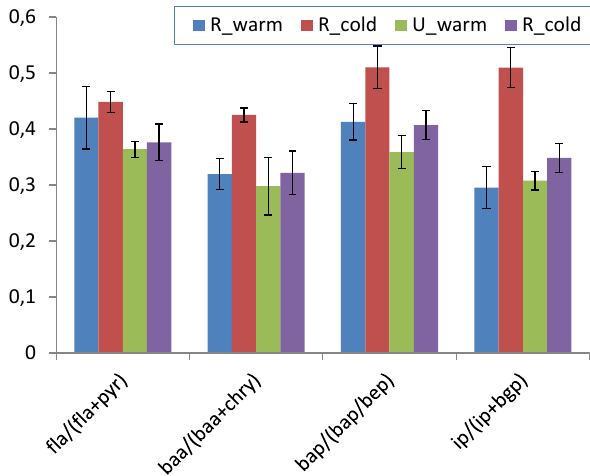
Figure 3. Isomeric PAH ratios for the different period (warm vs. cold) in the rural (R) and urban (U) sites. fla is fluoranthene; pyr is pyrene; baa is benz[a]anthracene; chry is chrysene; bap is benzo[a]pyrene; bep is benzo[e]pyrene; ip is indeno[123cd]pyrene; bgp is